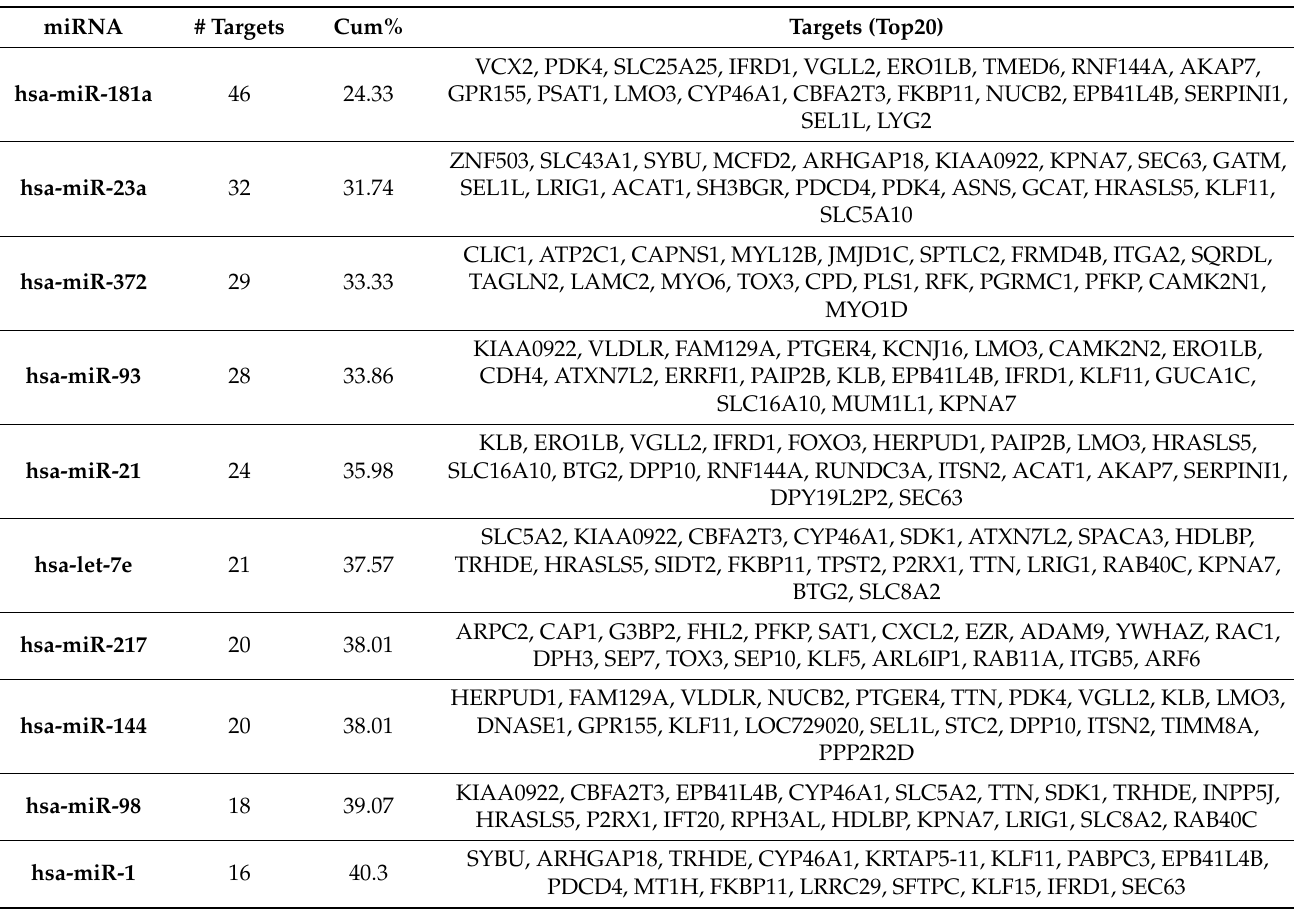
Table 2. Top 10 miRNA with more targets in common IPMN-PDAC miRNA-mRNA pairs. Each miRNA-mRNA pair has p val-corrected < 0.05 and appears at least 1 time in the following databases: tar-getScan_v7.1_17, miRSVR_aug10_17, miRDB_v5.0_21. Grey boxes correspond to up-regulated MiRNAs in IPMN/PDACvsH, white boxes correspond to downregulated miRNAs in